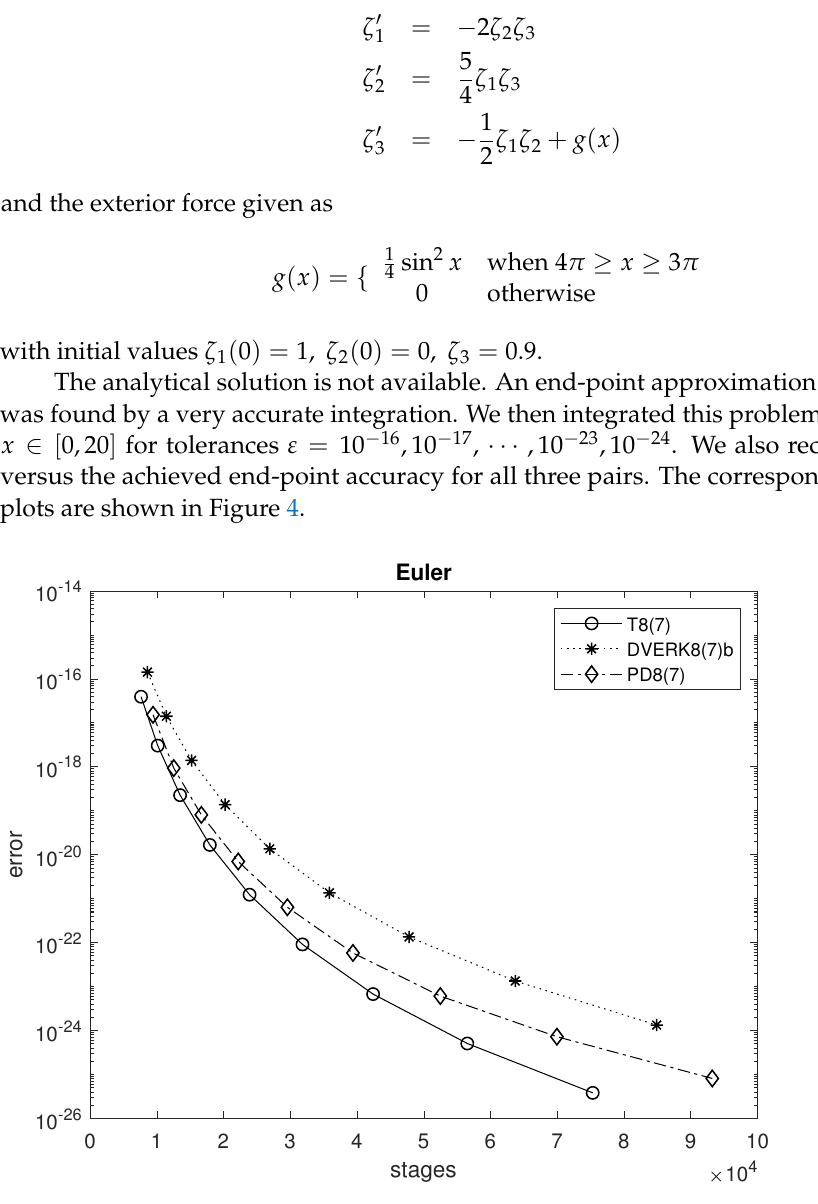
Figure 4. Efficiency plots for the Euler